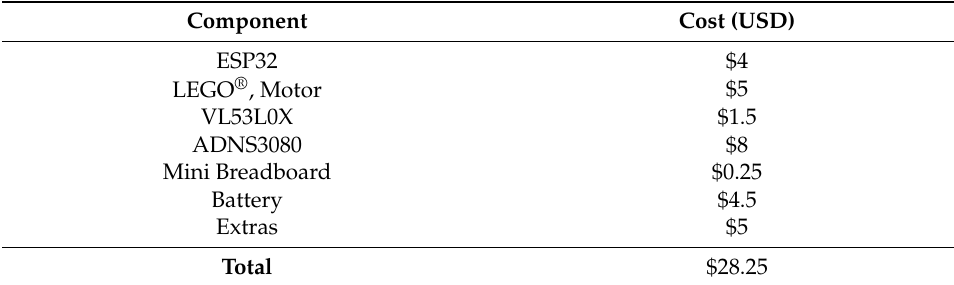
Figure 10. PL-Toon experimental platform. Table 1. Component costs for an